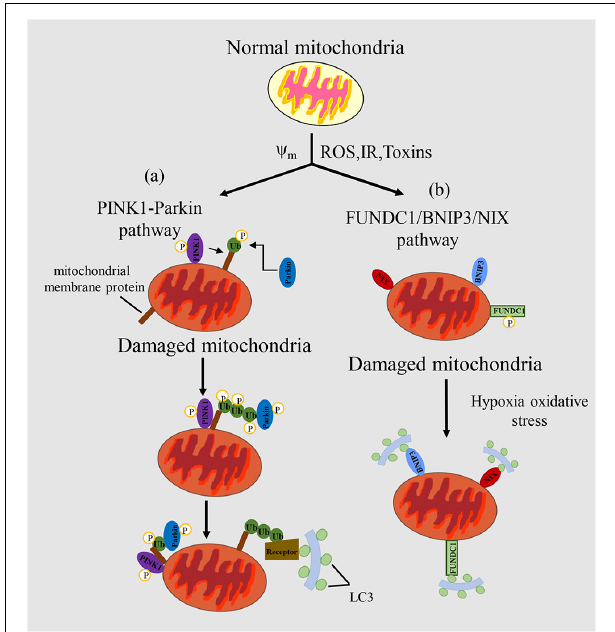
FIGURE 1 | Mechanism of mitophagy regulation in mammals. (a) In the PINK/PARKIN pathway, upon mitochondrial impairment or loss of mitochondrial potential, PINK1 can phosphorylate various target proteins, such as ubiquitin. Then, PINK1 recruits Parkin, and Parkin can amplify the signal through ubiquitination of miyochondrial surface receptor proteins. Receptor proteins can recognize the ubiquitinated proteins, which promotes mitochondria to form autophagosomes and eventually degrade them. (b) In the FUNDC1/BNIP3/NIX pathway, LC3 can be recognized by receptor proteins of mitochondria to promote the complementation of phagophores, thus targeting the mitochondrion for mitophagy. Mitochondrial outer membrane proteins FUNDC1, BNIP3 or NIX bind to LC3-II through their cytoplasmic LIR motifs to promote selective clearance of mitochondria. (cid:49) ψ m , mitochondrial potential; ROS, reactive oxygen species; IR, ischemia/reperfusion; Toxins, poisons produced naturally by